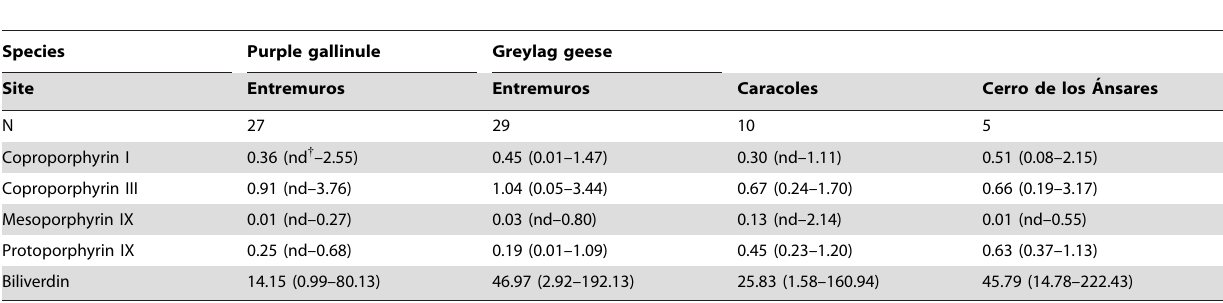
Table 2. Geometric mean (range) of porphyrins and biliverdin concentrations (nmol/g dry weight) in feces of greylag geese and purple gallinule collected at different sites in Don˜ana.